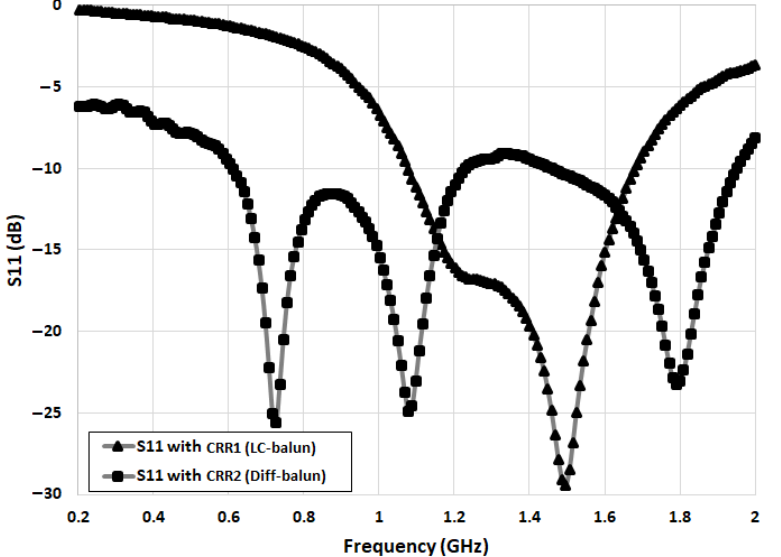
Figure 12. The S11 performance of CRR1 and CRR2 versus the RF